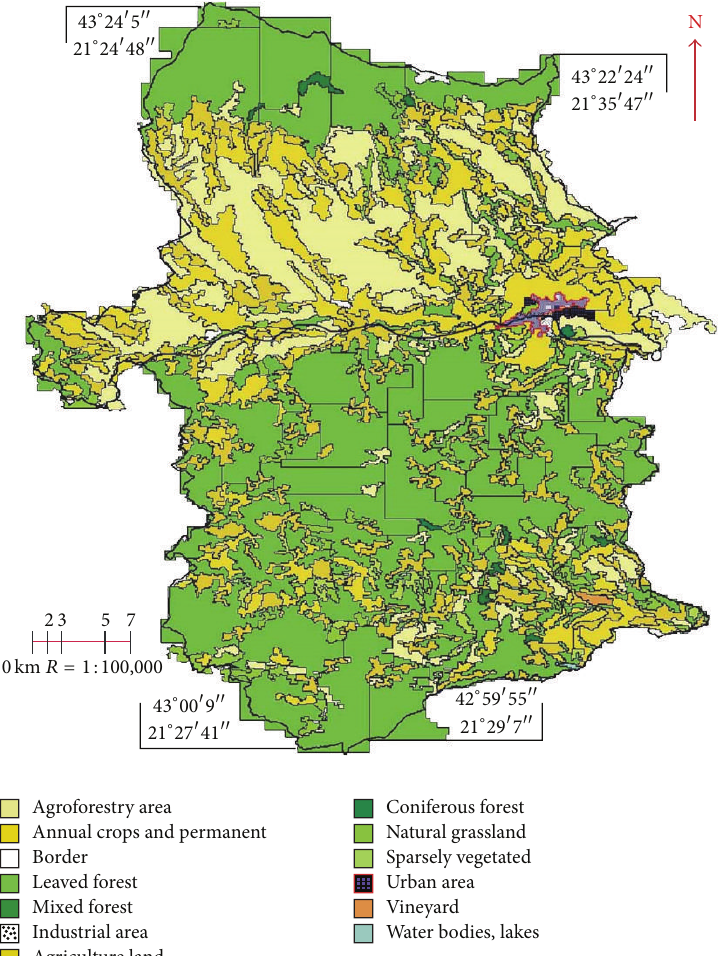
Figure 1: Digitized map of land cover on the territory of the Prokuplje Municipality in